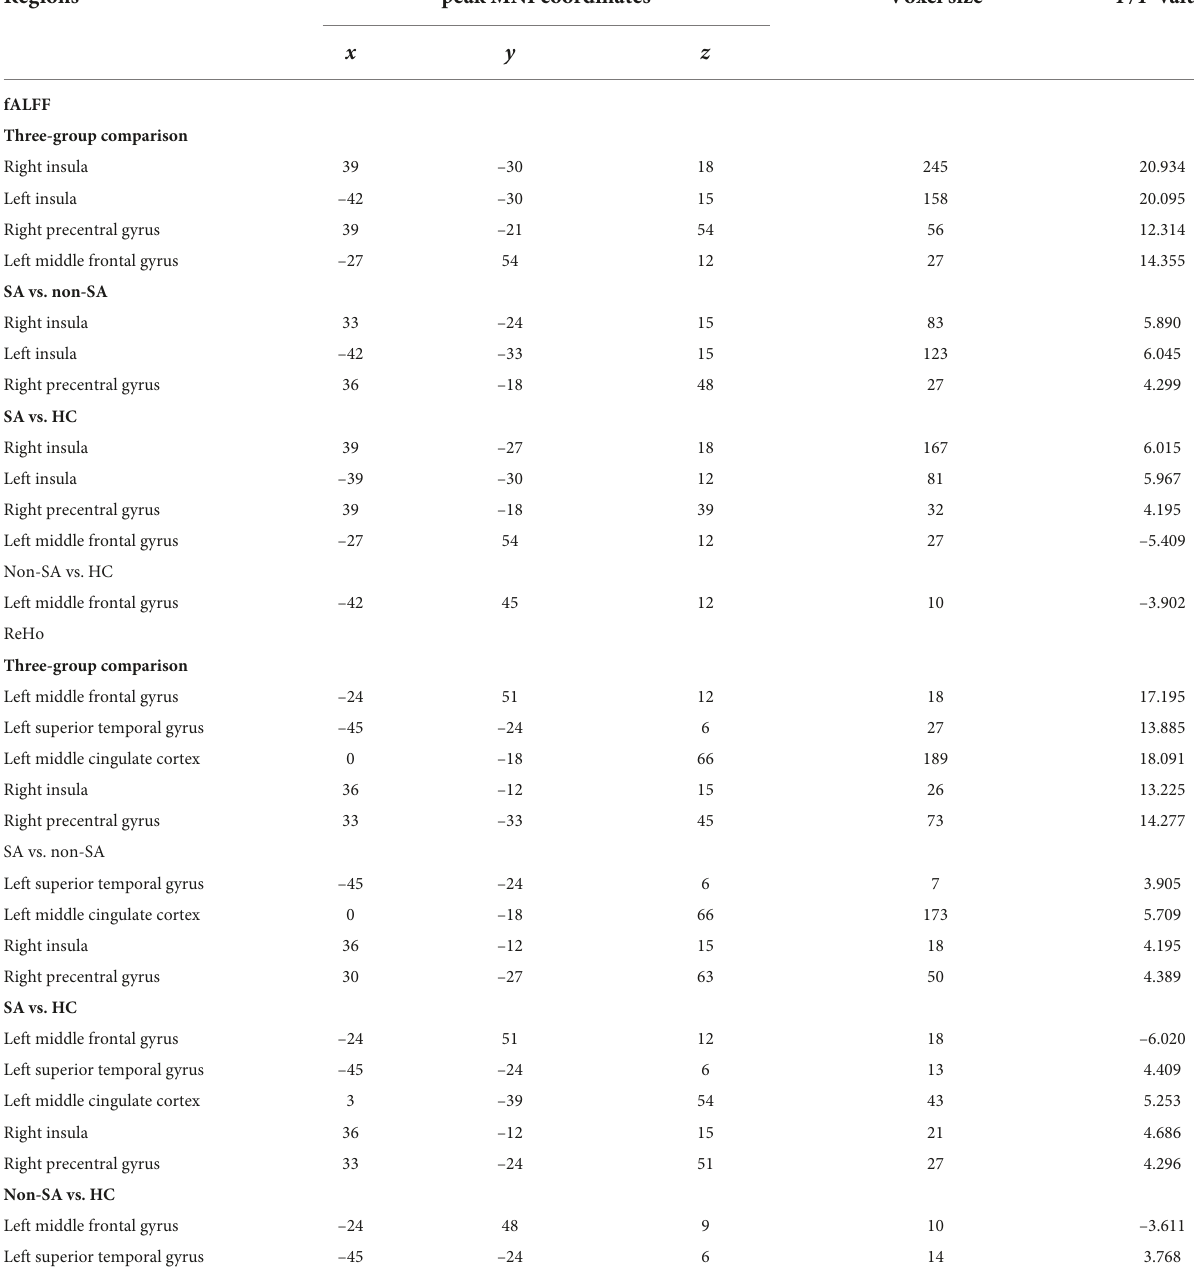
TABLE 2 Significant differences in fALFF and ReHo among SA, non-SA, and HC